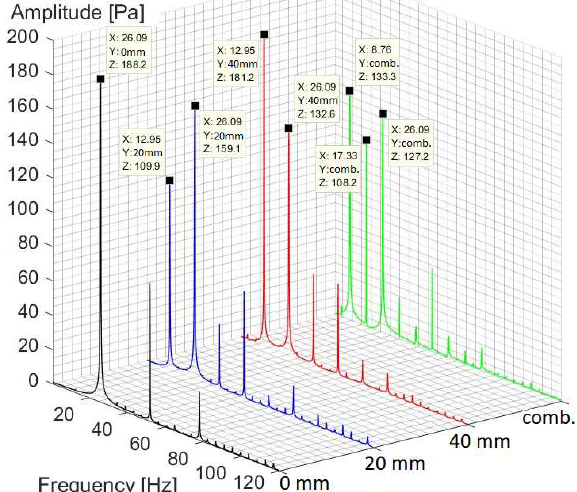
Fig. 13 Amplitude-frequency characteristics calculated from point 2 for static pressure (behind the rib at centre streamline)